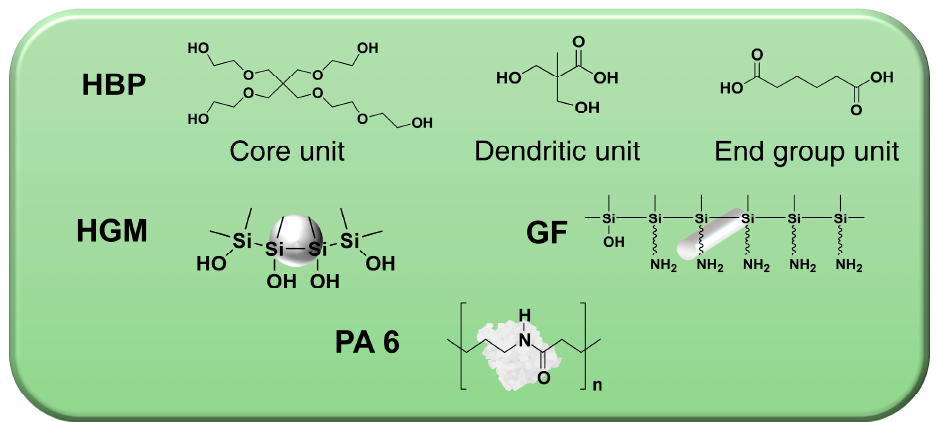
Figure 1. Chemical structures of PA 6, HGM, GF, and HBP.